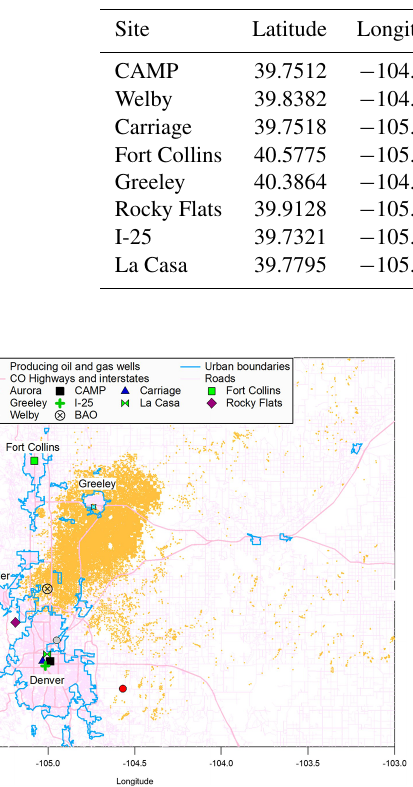
Figure 1. Site map for O 3 and NO 2 measurements in the NFRMA identified by shapes and colors. Producing oil and gas wells as of 2012 are identified on the map with gold dots. Urban areas are out- lined with thick light-blue lines. Major interstates and state high- ways are identified by thick pink